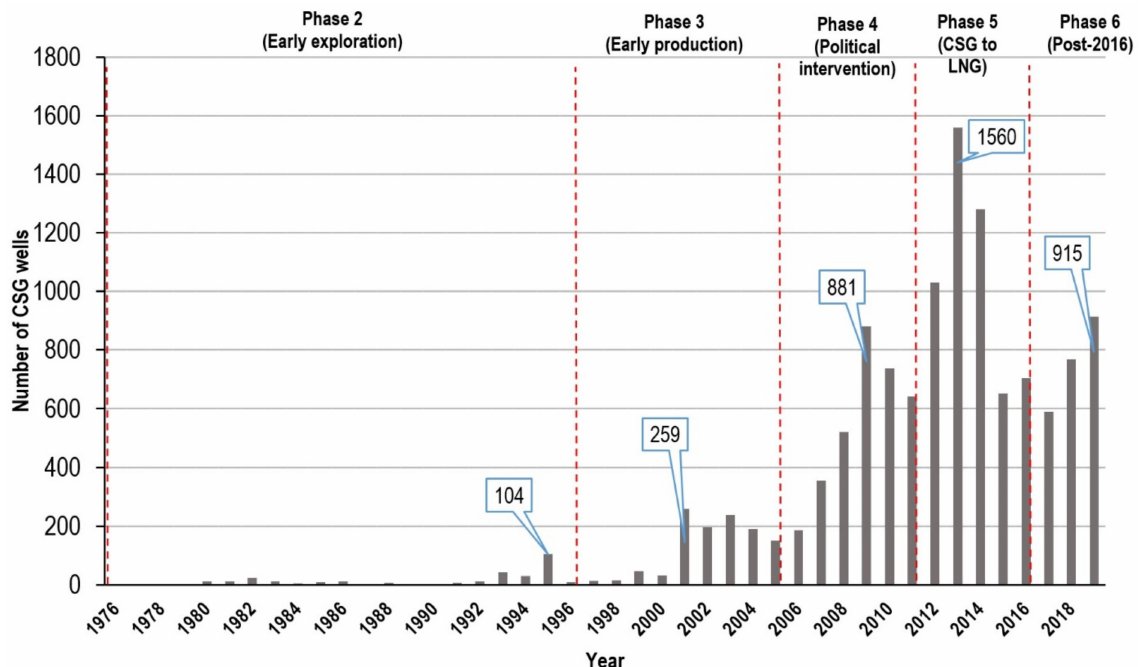
Figure 3. Number of CSG wells drilled per year in Australia since the 1980s